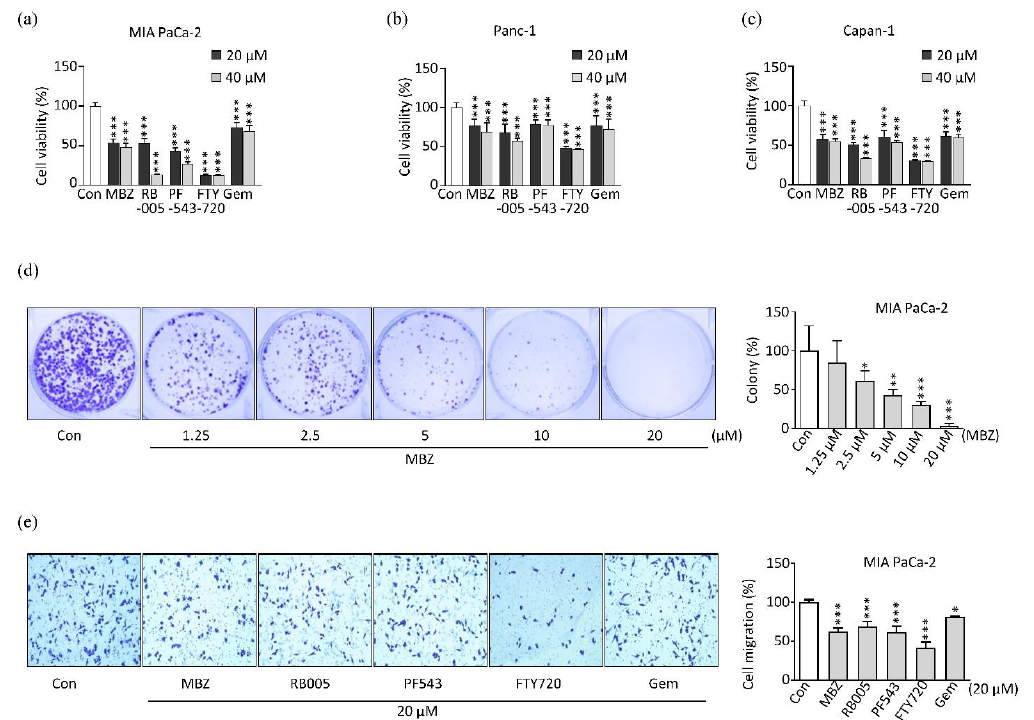
Figure 2. Mebendazole inhibits the viability, proliferation and migration of PDAC cell lines: ( a – c ) cytotoxic effect exerted by MBZ, RB005, PF543, FTY720 and gemcitabine treated with 20 and 40 µM each on PDAC cell lines: MIA PaCa-2, Panc-1 and Capan-1, respectively; ( d ) colony formation in MIA PaCa-2 cell line after 24 h treatment with different concentrations (1.25 µM, 2.5 µM, 5 µM, 10